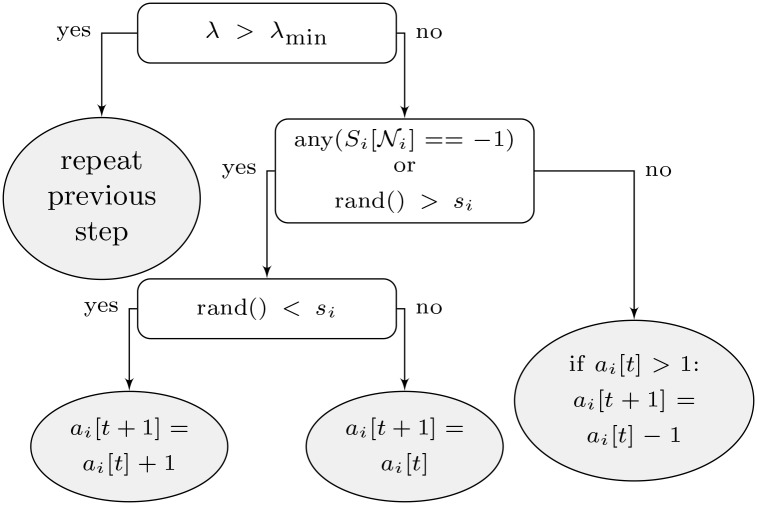
Schematic of agent i’s decision procedure.